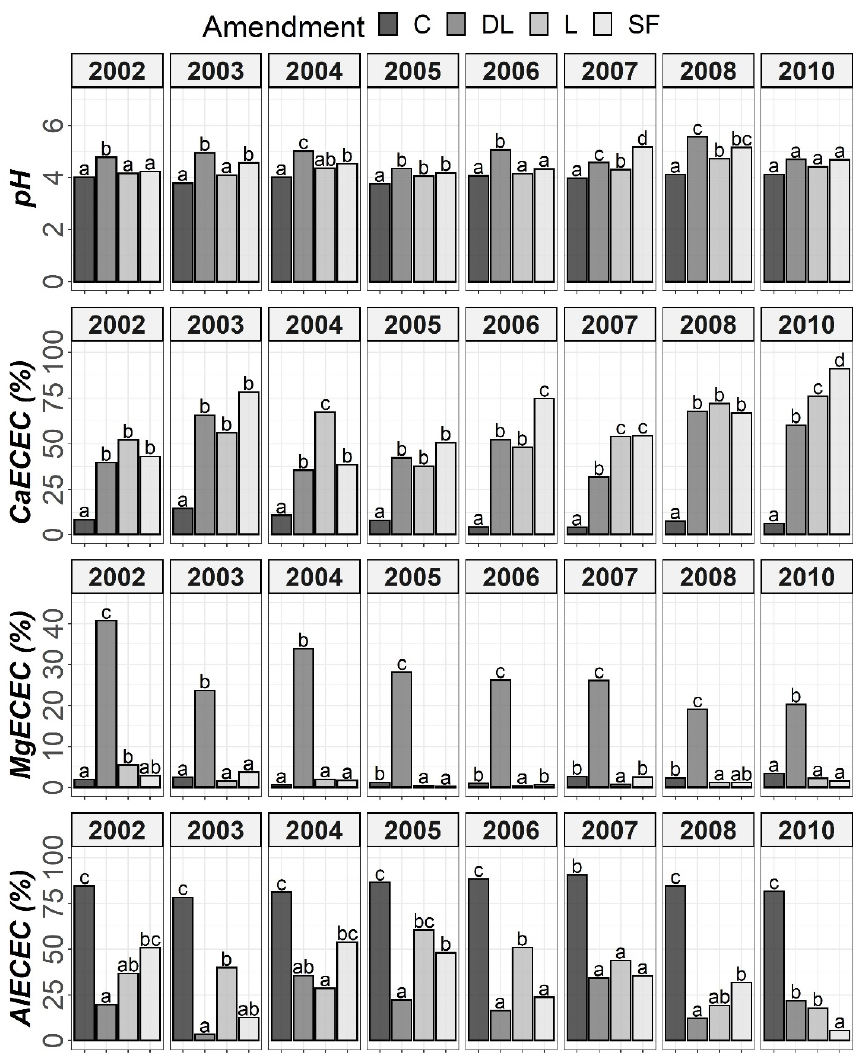
Figure 4. Temporal evolution of pH, CaECEC, MgECEC and AlECEC in the Ap2 horizon throughout the soil monitoring period (2002–2010). Bars within each year followed by different lowercase letters reflect significantly different averages according to Tukey’s honest significance test with Holm–Bonferroni adjustment ( p = 0.05).